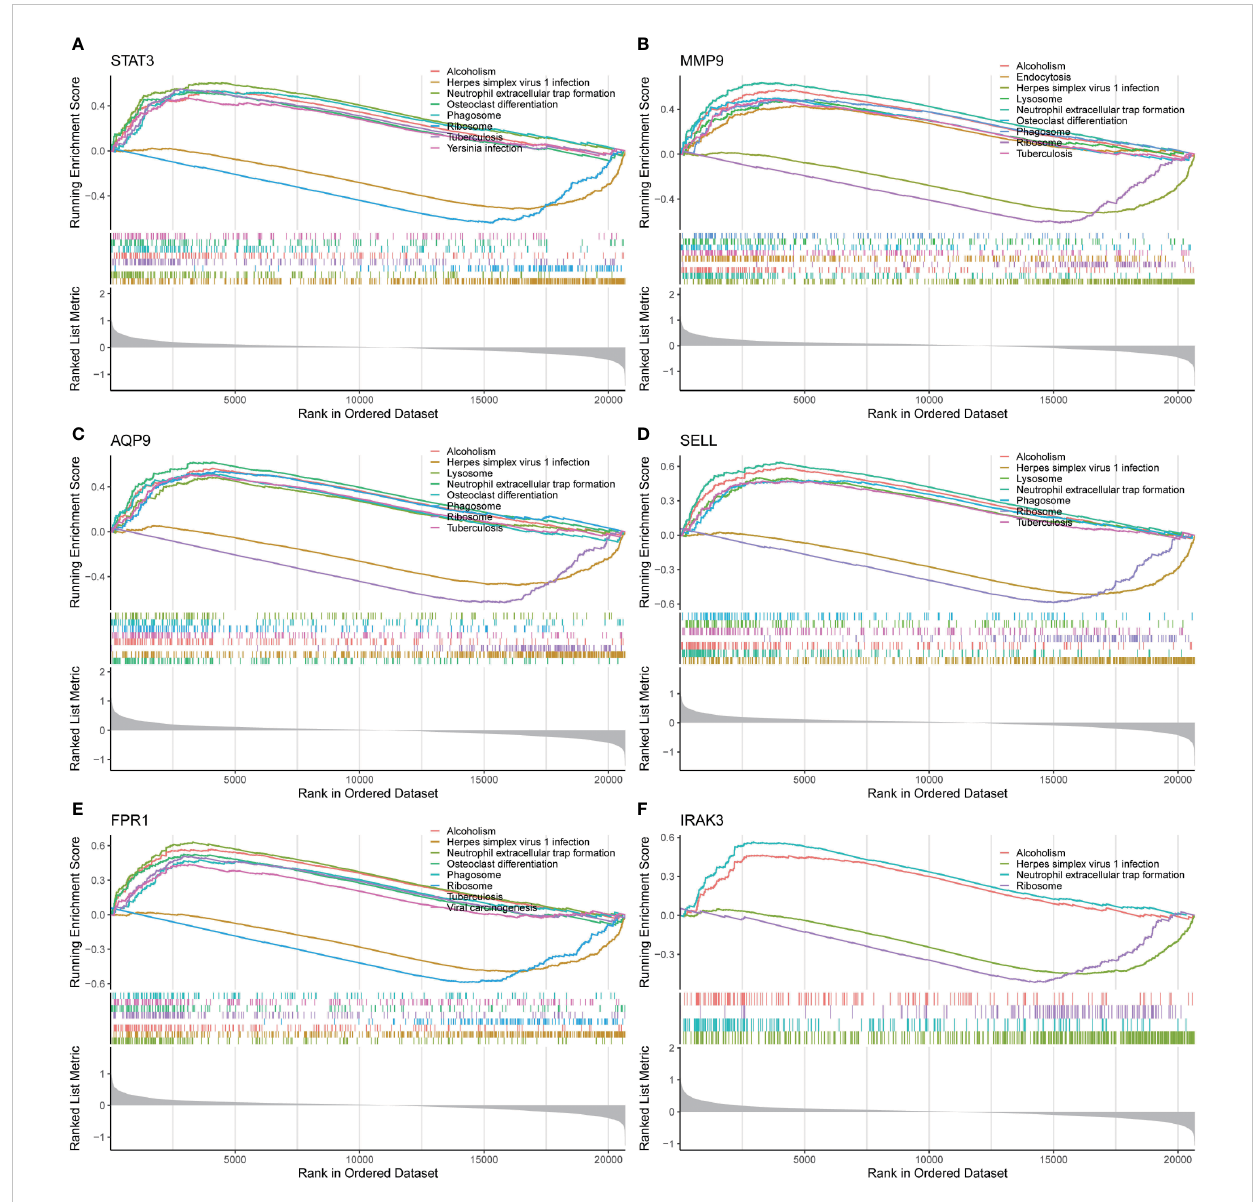
FIGURE 7 Single-gene GSEA analysis for 6 real critical genes. (A) STAT3, (B) MMP9, (C) AQP9, (D) SELL, (E) FPR1, (F)